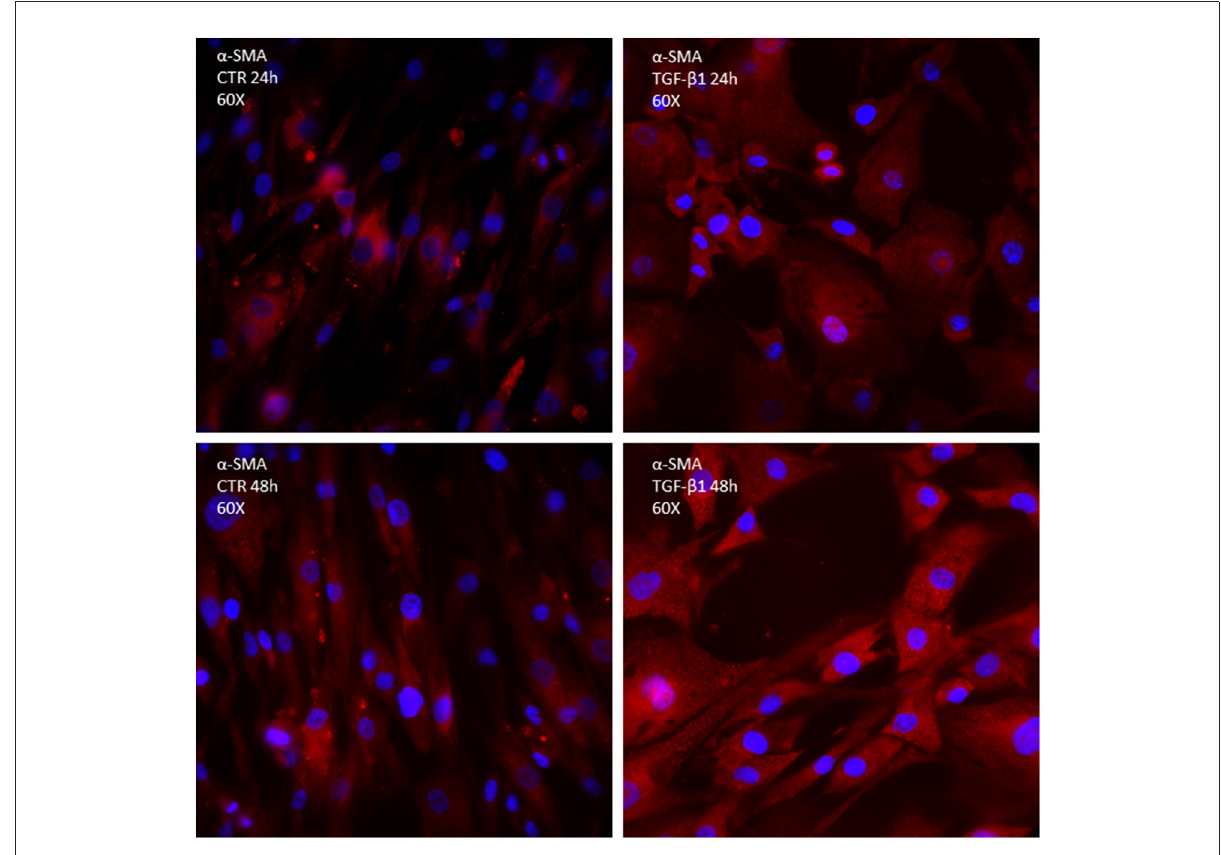
FIGURE2 Immunocytochemistry of primary culture of fibroblasts isolated from human biopsies of patients undergoing cardiosurgery for obstructive human hypertrophic cardiomyopathy; α -SMA is marked in red; DAPI is marked in blue.